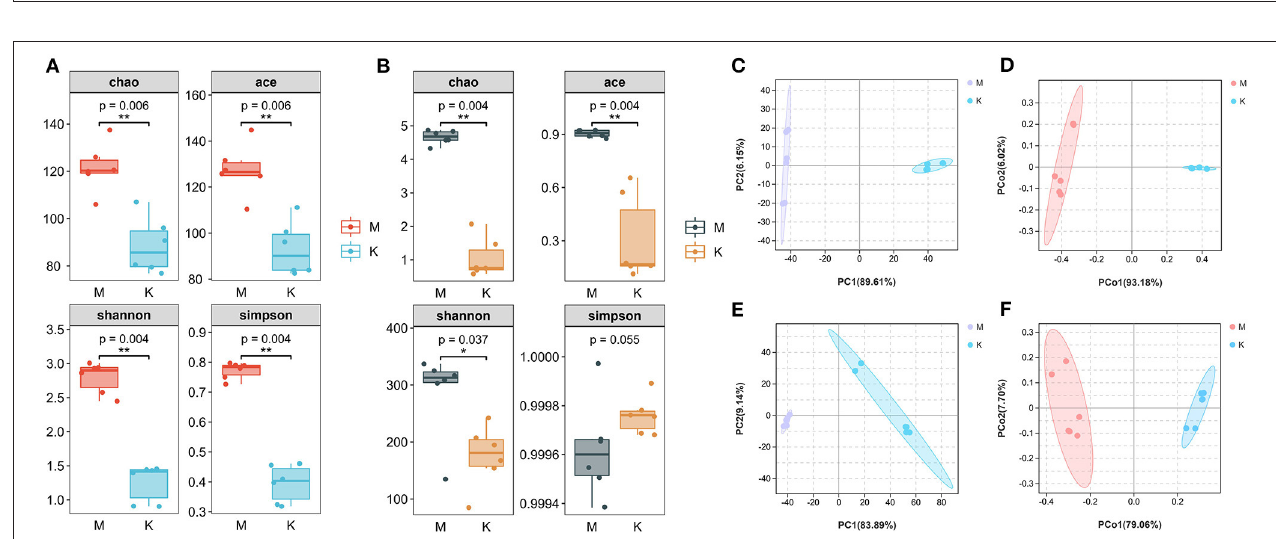
FIGURE 1 | Volcano plots and Structures of differential compounds for the two groups of samples.